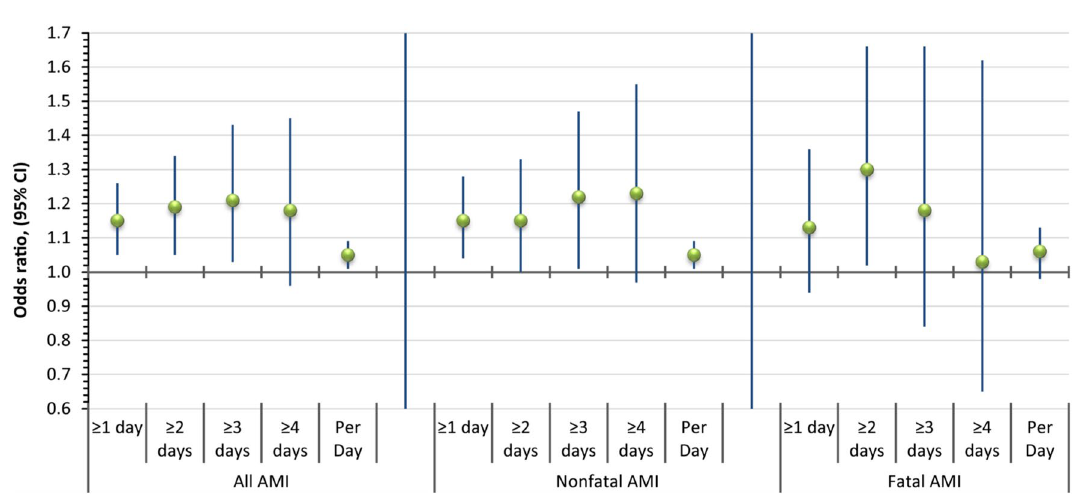
Figure 1. Associations between ≥ 1, ≥ 2, ≥ 3, and ≥ 4 winter cold spell days and AMI in Kaunas, 2000–2015, expressed as odds ratios and 95% confidence intervals.